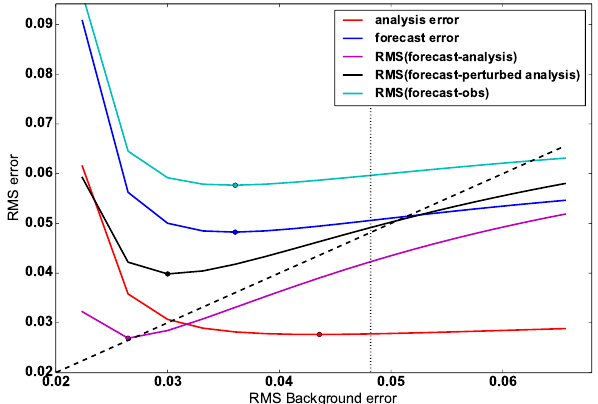
Figure 4. RMS error of the forecast and analysis as plotted in Fig. 1, but using an ensemble with only 10